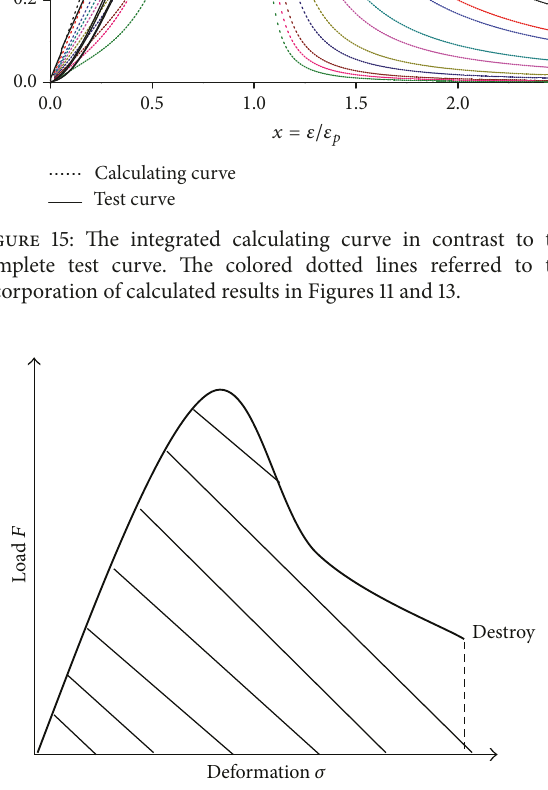
Figure 16: The toughness of the